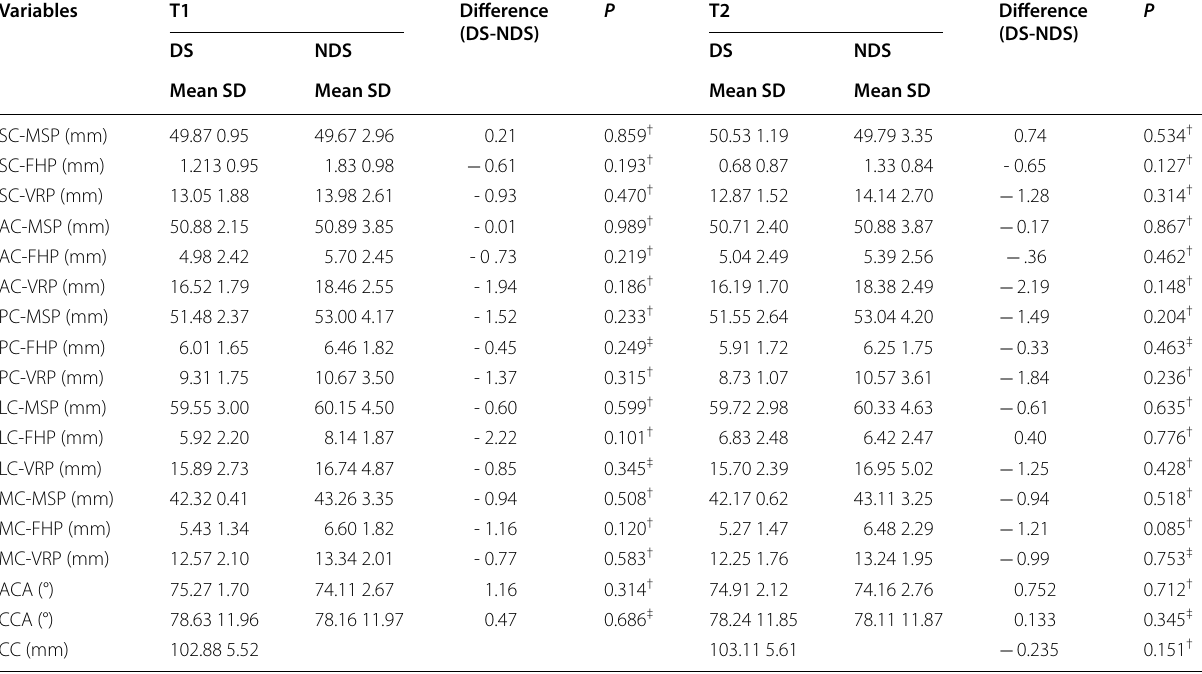
Table 3 Comparison of condylar position and angle between deviated and non-deviated sides at T1 and T2, respectively (cranial base